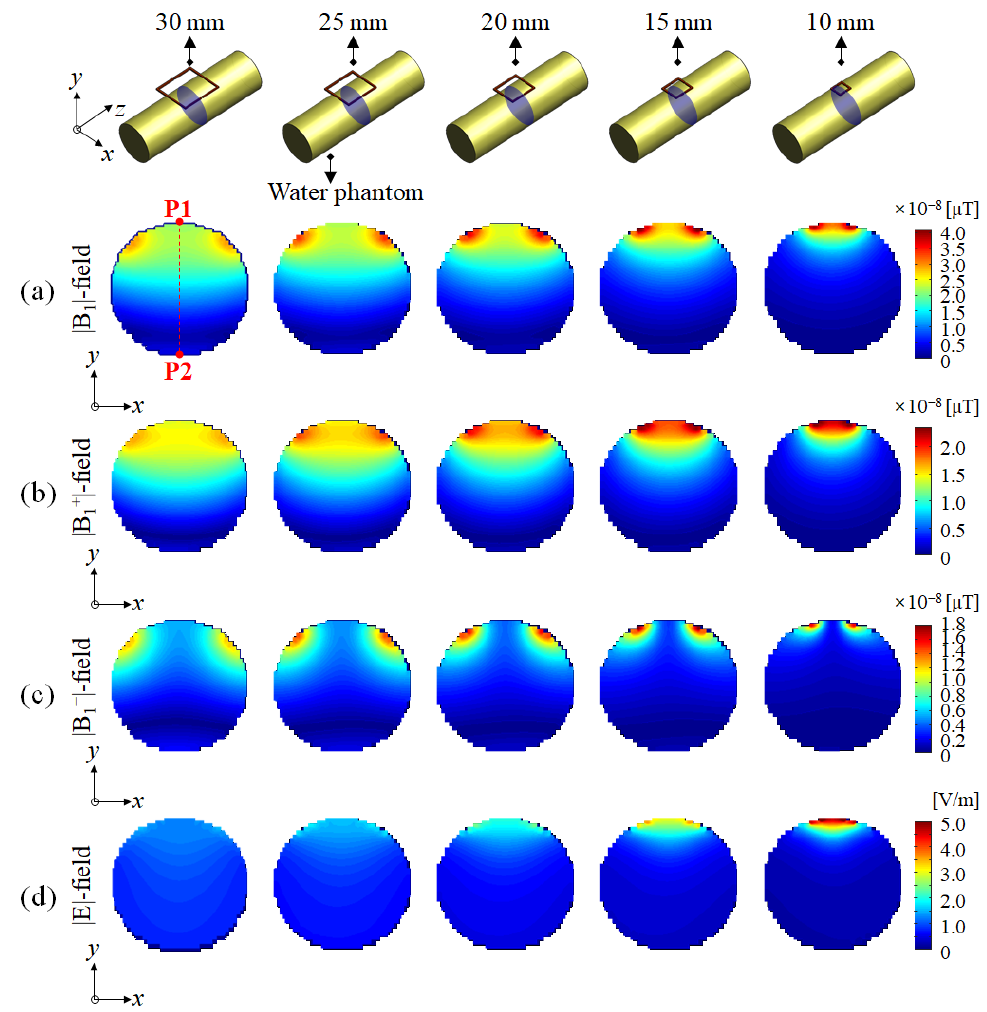
Figure 3. EM-field simulation results using water phantom in the axial slice ( x - y plane): ( a ) |B 1 |-field, ( b ) |B 1+ |-field, ( c ) |B 1 − |-field, and ( d ) |E|-field.